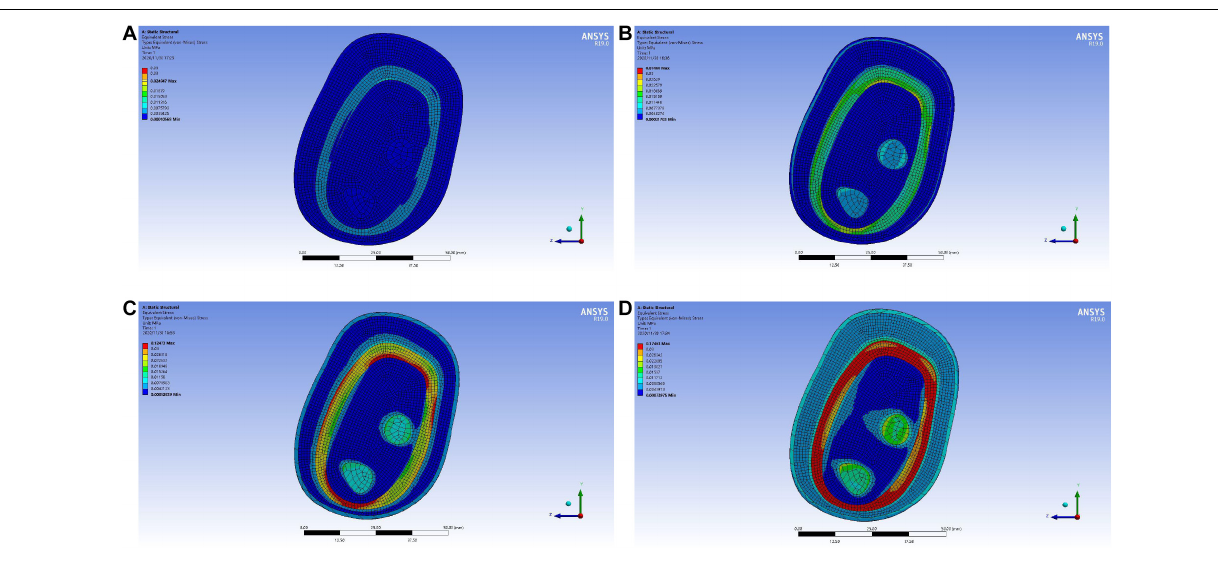
Frontiers in Bioengineering and Biotechnology |